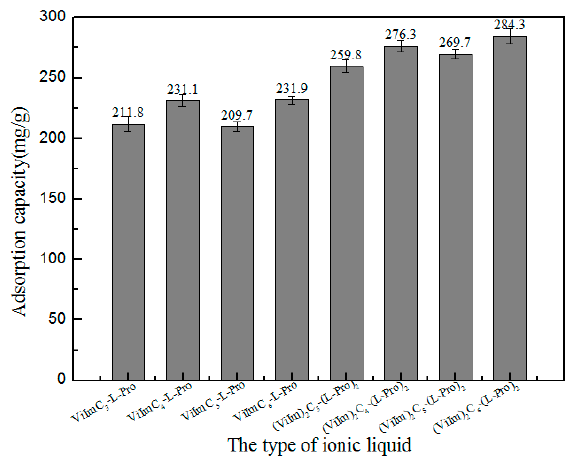
Figure 8. The types of ILs.